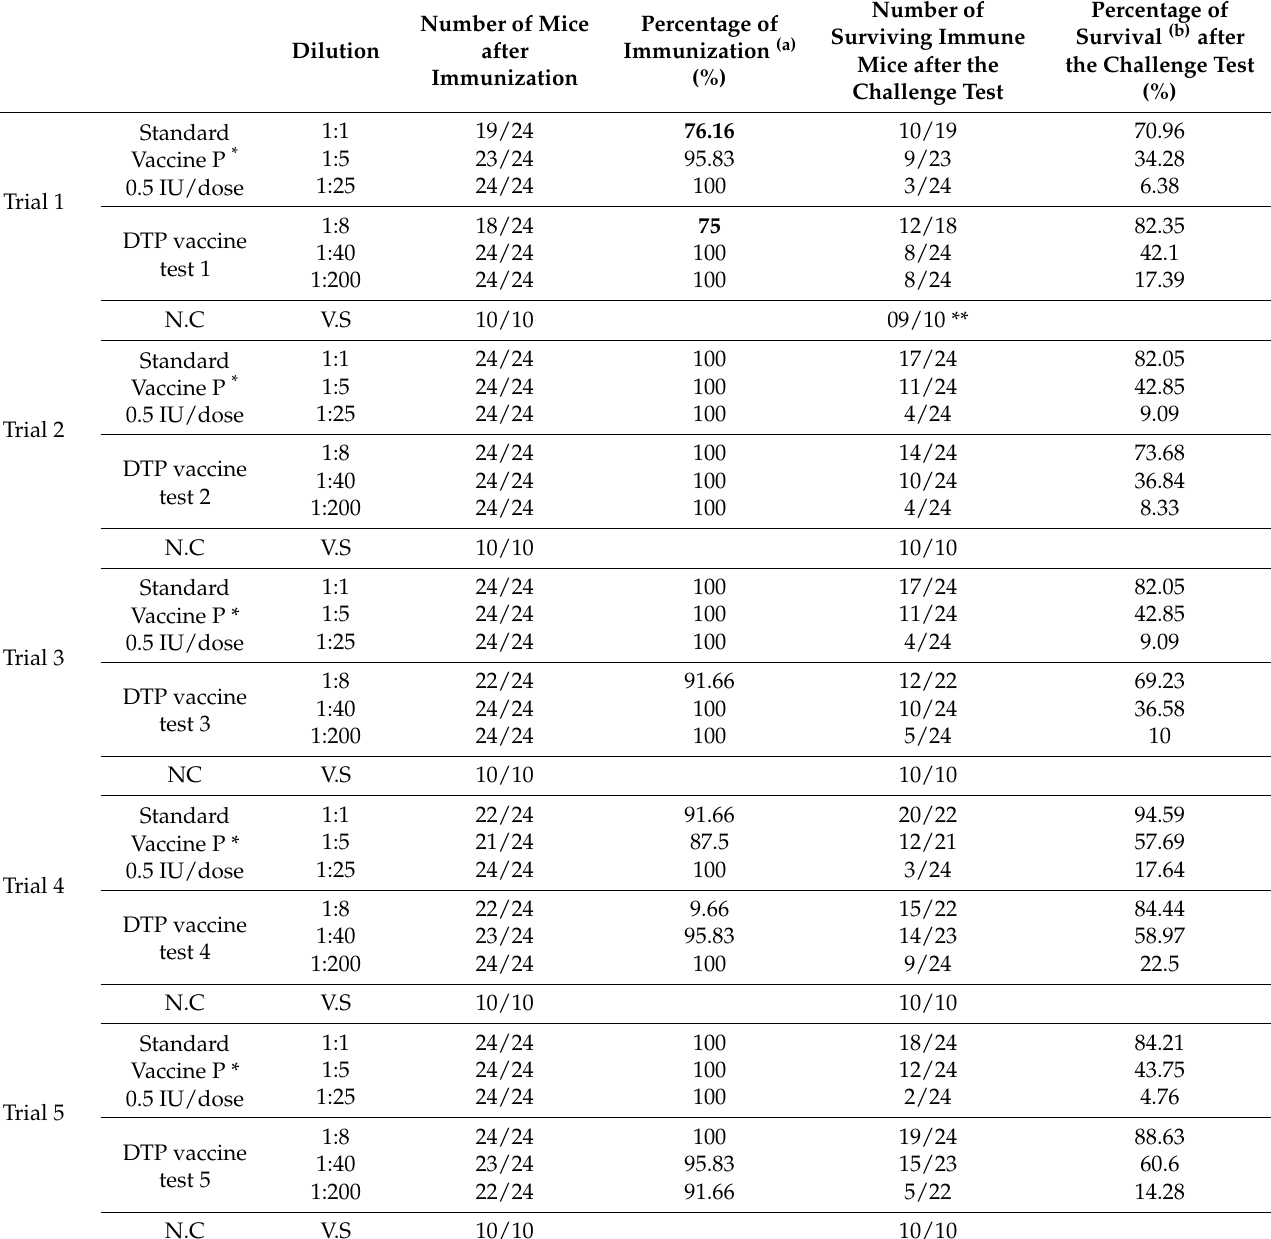
Table 2. Mouse protection test results of the pertussis component of the DTP vaccine trials (vaccine test 1, 2, 3, 4, 5): Percentage of immunization before the challenge test and percentage survival